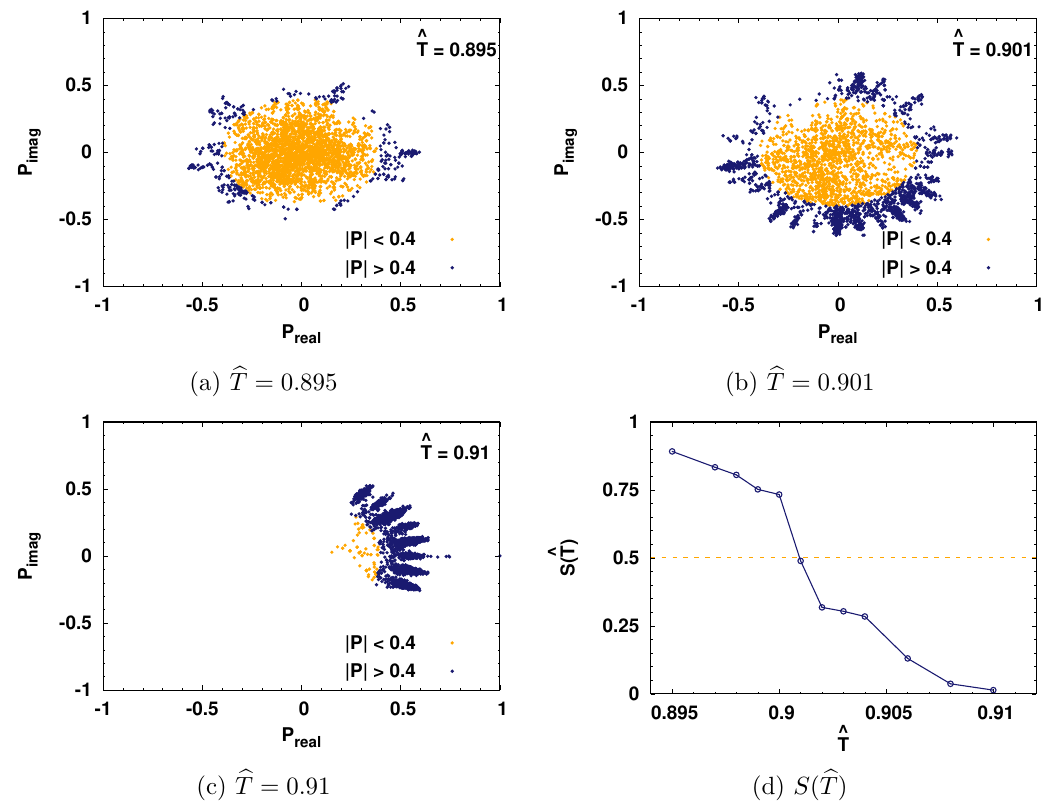
Figure 3. Polyakov loop scatter plots for N = 32 with µ = 1 for three values of b T . The separatrix is b a circle of radius r = 0 . 4 shown by the two colors. Panel (d) shows the resulting S ( b T ) that identifies S the critical temperature b T 0 . 901 . (Note the b T = 0 . 903(1) in table 1 comes from N = 48 c ≈ c